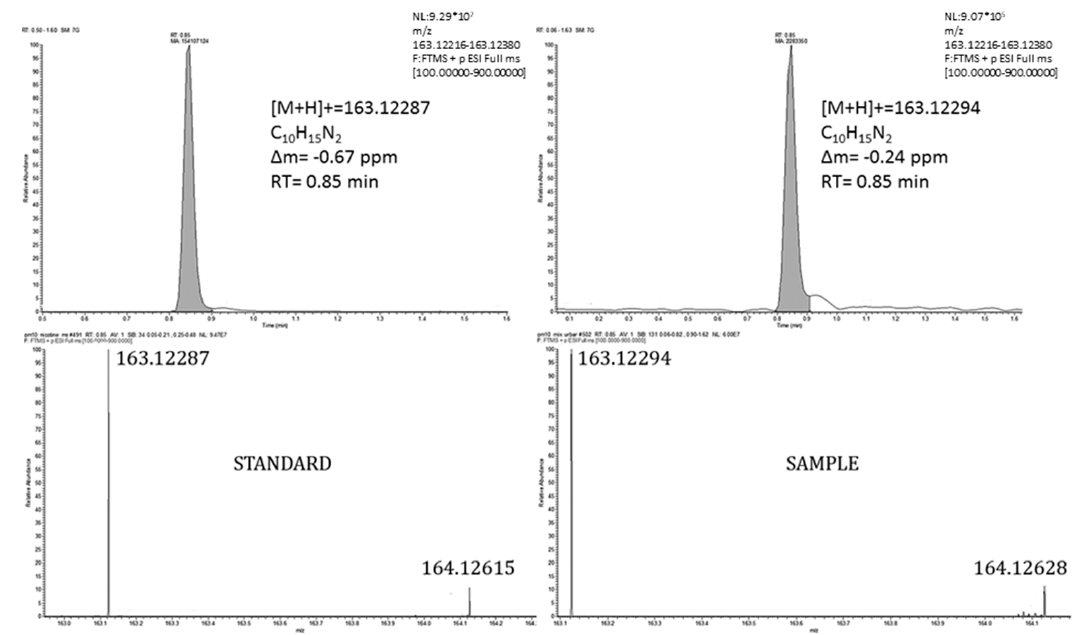
Figure 4. Extracted ion chromatogram ( top ) and isotopic profile ( bottom ) corresponding to the protonated molecule of nicotine in a standard ( left ) and a real sample ( right ).